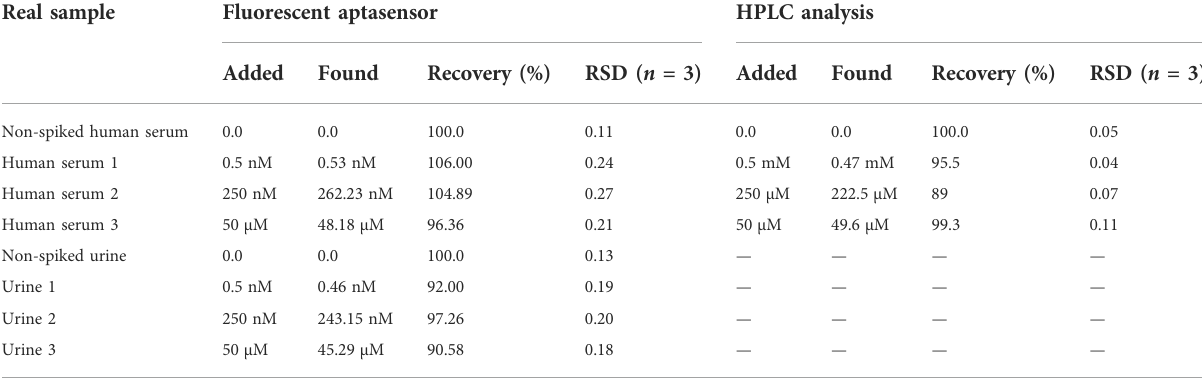
TABLE 1 Quanti fi cation of cocaine in the real samples by the fl uorescent aptasensor and HPLC analysis. Real